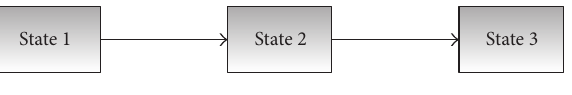
Figure 3: Basic three-state model.